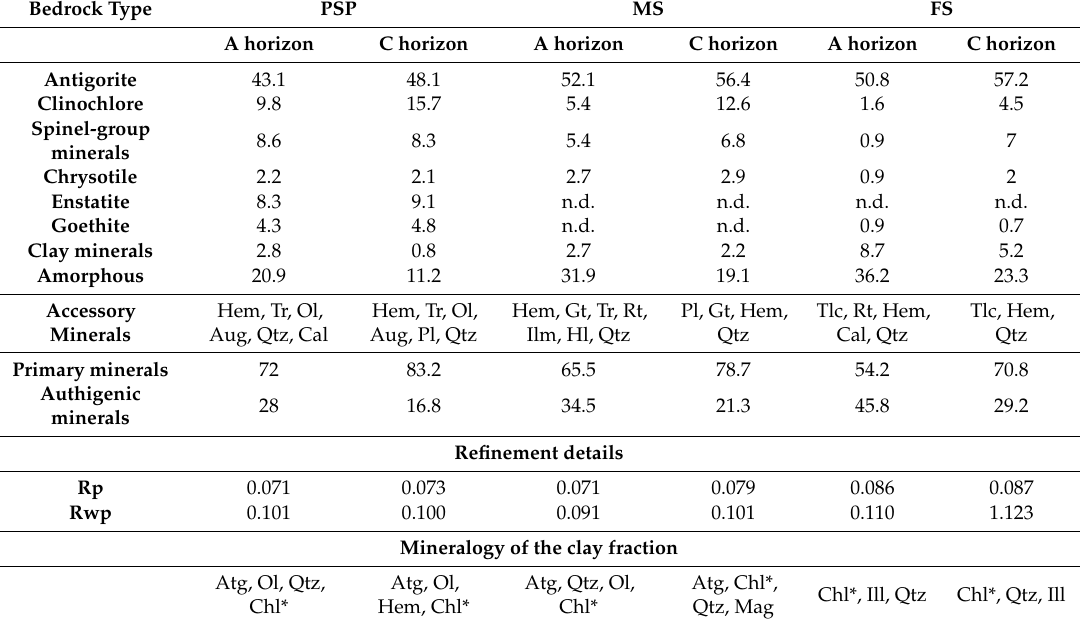
Table 1. Mineralogy of soils on PSP, MS and FS, resulted from Synchrotron Radiation XRPD analyses and Rietveld refinement, and of the separated clay fraction ( < 2 µ m) after glycolation and thermal treatment. Data (expressed in weight percentage—wt %) represent the mean (three samples) resulting from the recalculations of the values obtained in the three grain-size fractions (sand, silt, and clay fractions). Accessory minerals were recognized by SEM–EDS and EMPA–WDS analyses. The sum of the primary and authigenic minerals is reported at the bottom of the table. Primary minerals include Atg, Clc, Spl, Ctl, and En, whereas authigenic minerals include Gt, clay minerals, amorphous and / or low crystalline